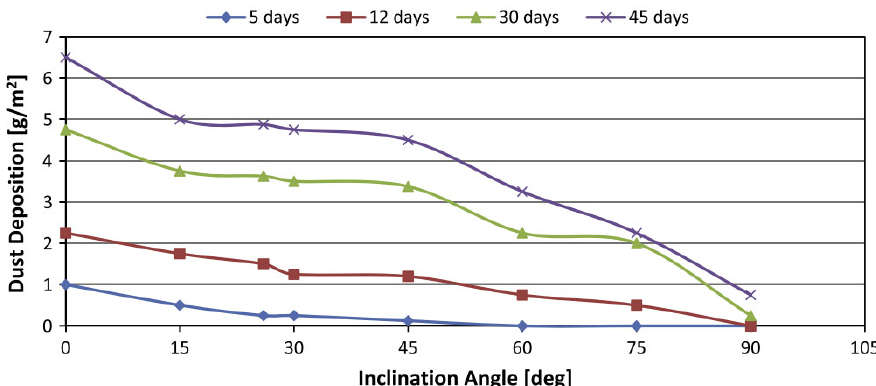
Figure 9. Dust deposition with tilt angle for various exposure periods. Reprinted from Solar Energy, 107, Said, Syed A.M. et al., Fundamental studies on dust fouling effects on PV module performance, 333., Copyright (2014), with permission from Elsevier [59].